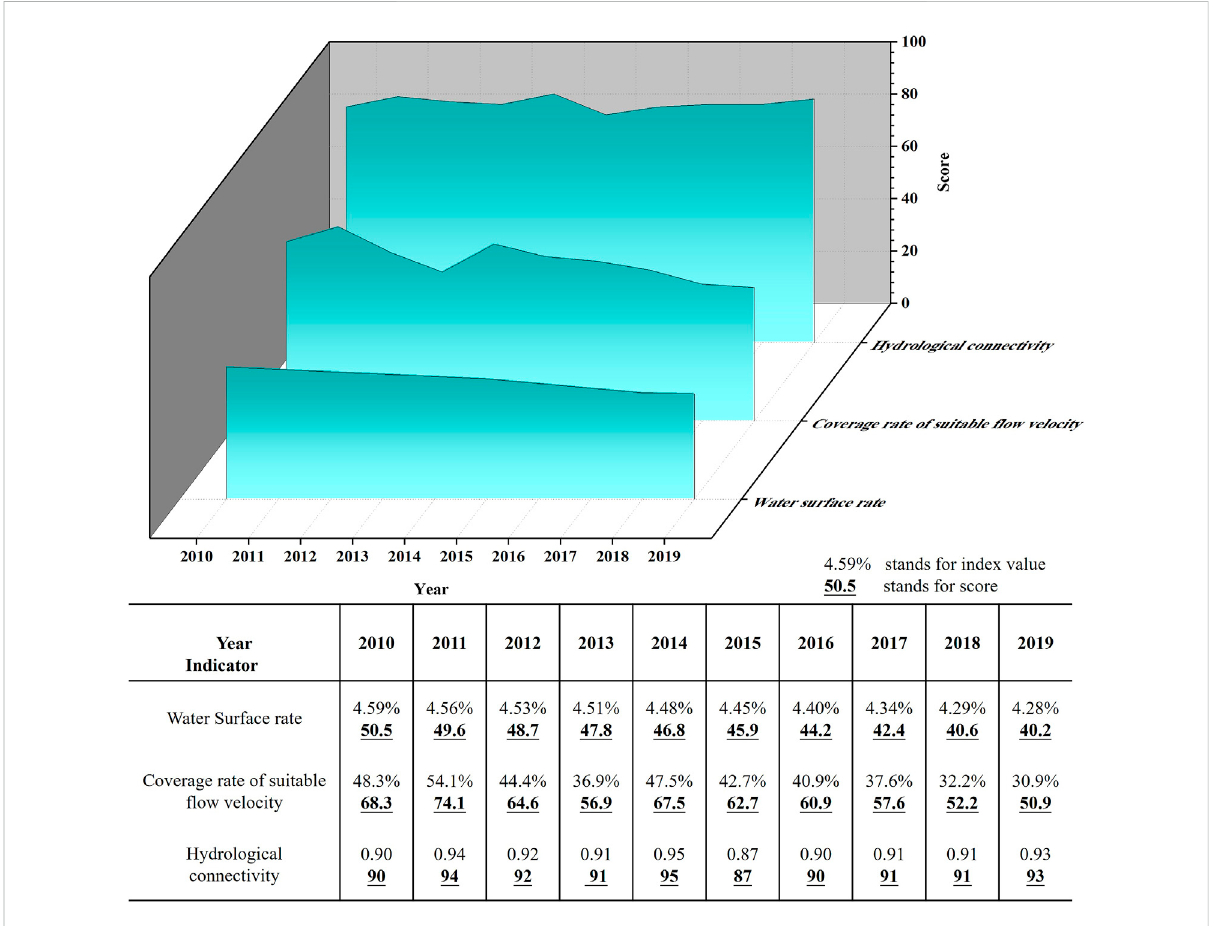
FIGURE 4 Results of the assessment of river network